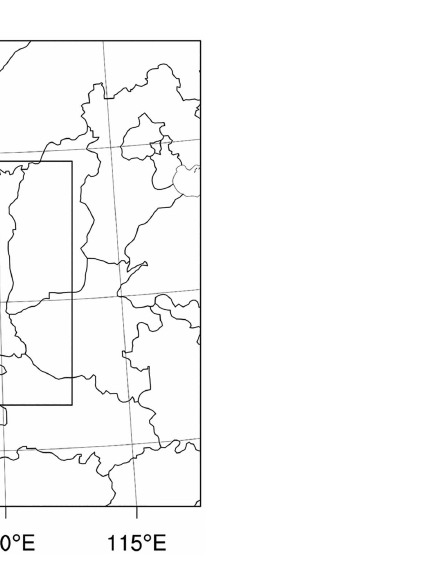
Fig 2. Nested computational domains in the WRF model